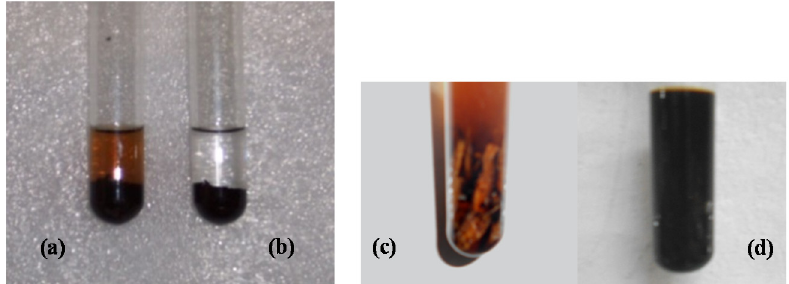
Figure 2. Samples of activated carbon in contact with ammonia solution (25%). ( a ) Exhausted granular activated carbon (GAC) from the rum production process and ( b ) virgin GAC; white oak wood chips after ( c ) 15 min and ( d ) 12 h.